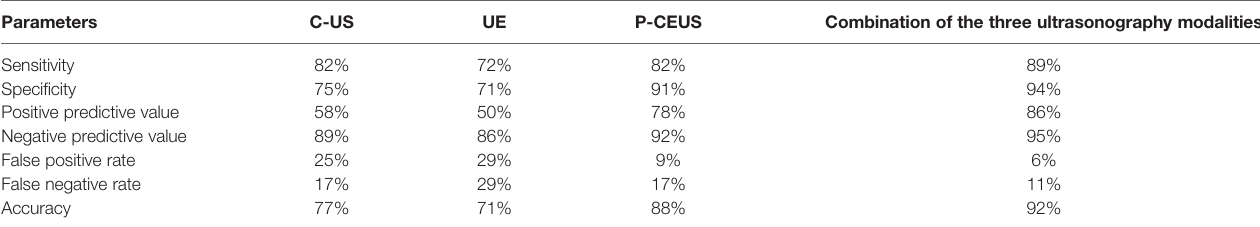
TABLE 3 | Diagnostic ability of C-US, UE, P-CEUS, and the three modalities combined. Parameters C-US UE P-CEUS Combination of the three ultrasonography modalities Sensitivity